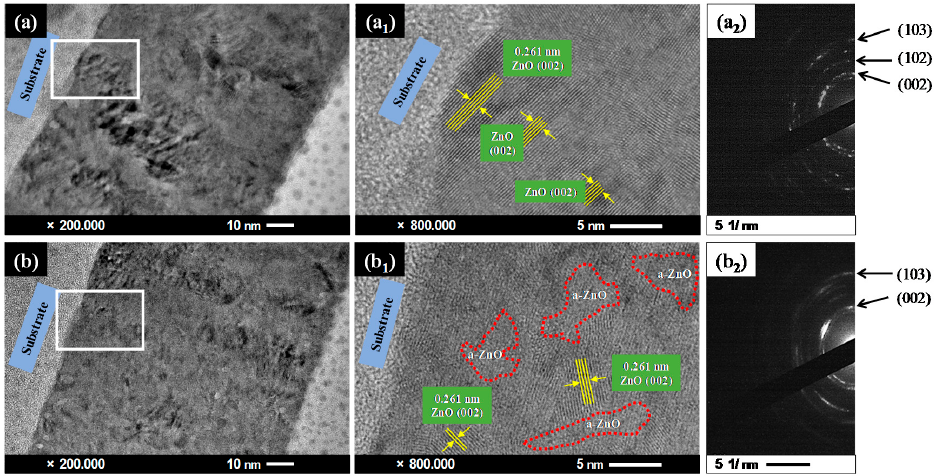
Figure 3. TEM observation and the corresponding high-resolution TEM images of Ga-doped ZnO (GZO) films deposited with Ga 2 O 3 powers of 30 W ( a , a 1 ) and 50 W ( b , b 1 ), and their electron diffraction patterns: 30 W ( a 2 ) and 50 W ( b 2 ).